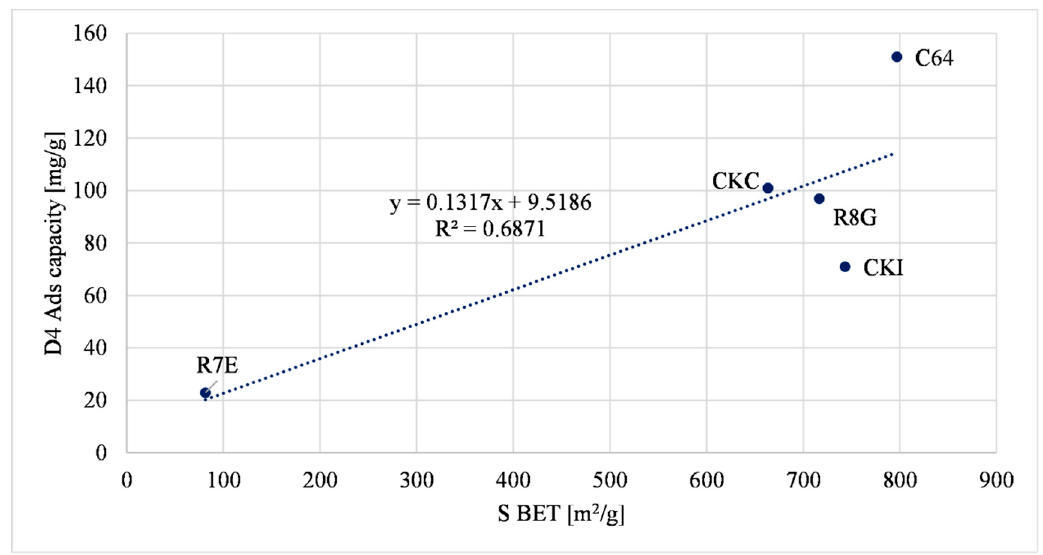
Figure 3. S BET correlation with D4 adsorption capacity.